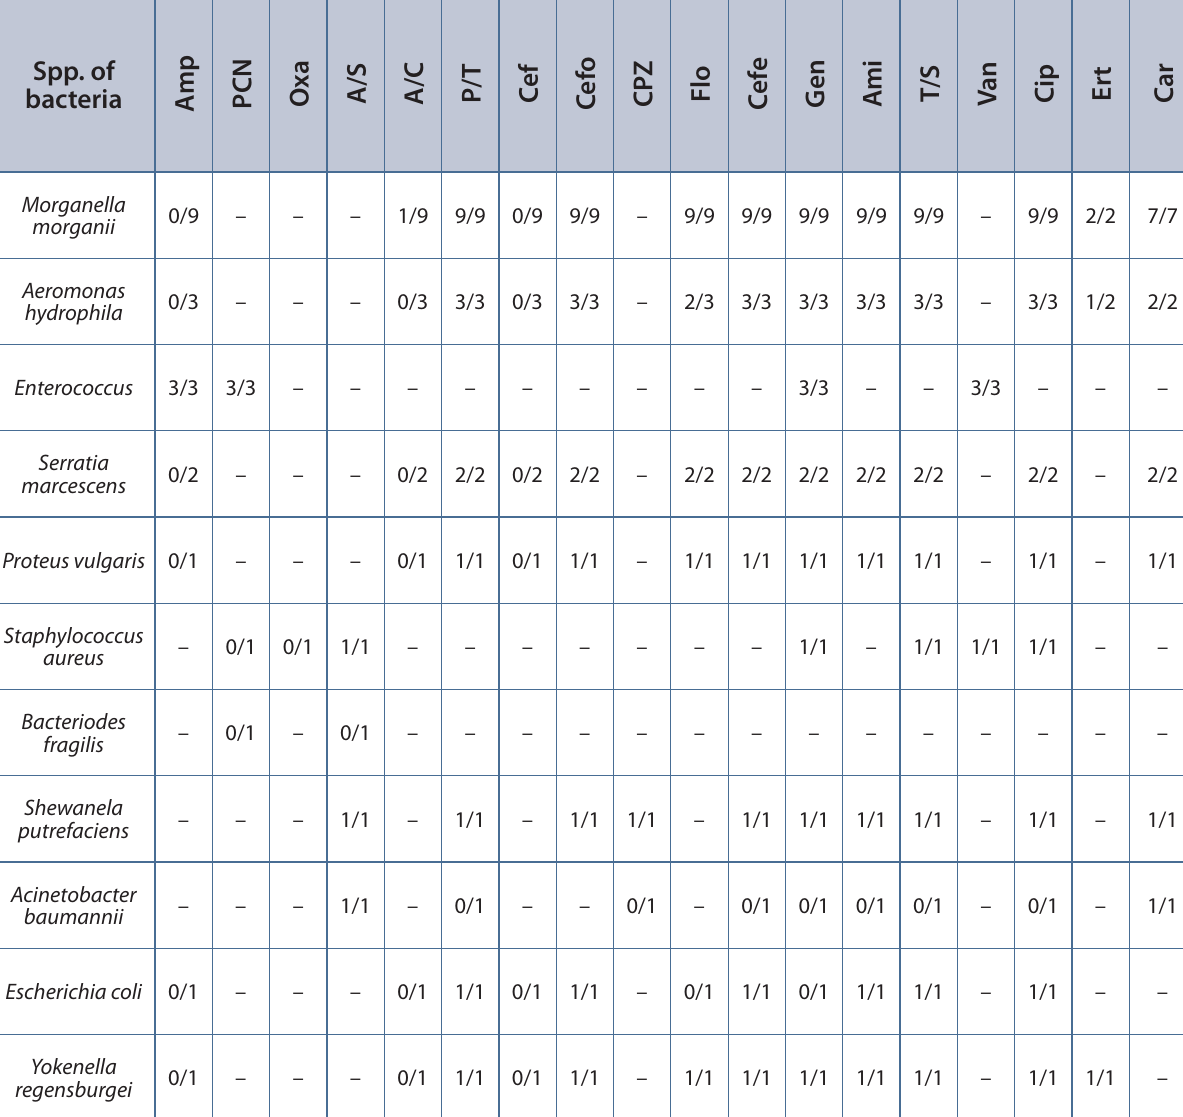
Table 3. Susceptibility of bacteria isolated from snakebite wounds to common antibiotics* Spp. of bacteria